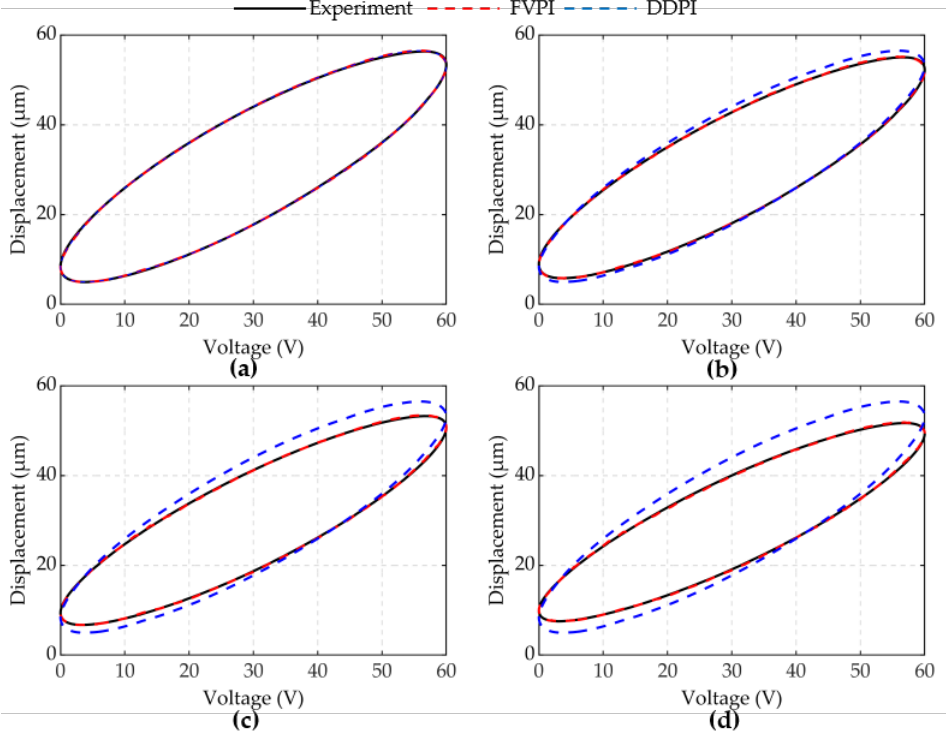
Figure 8. Comparison of two models at 250 Hz under different forces: ( a ) spring 1; ( b ) spring 2; ( c ) spring 3; ( d ) spring 4.